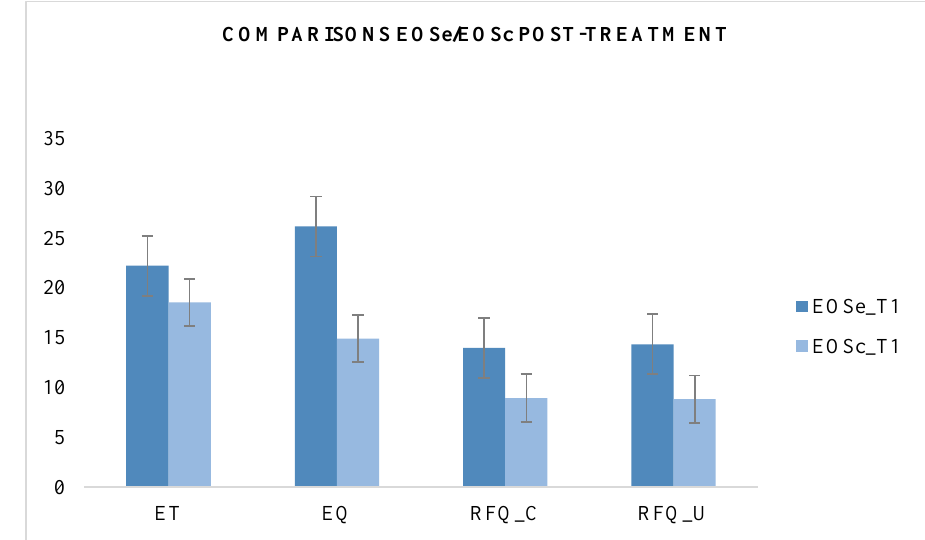
Figure 3. Comparison between EOSe and EOSc at T1.